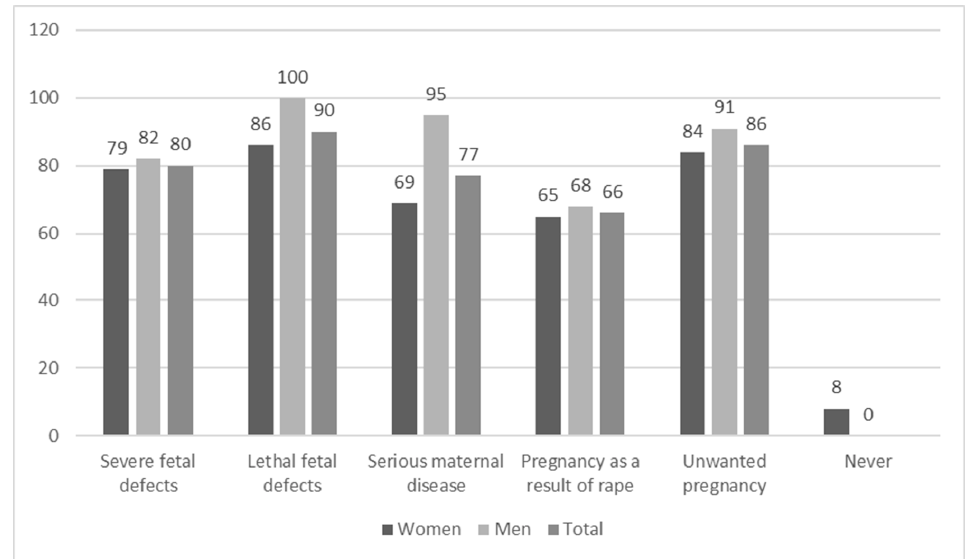
Figure 2. Declaration to perform pregnancy termination depending on the respondent’s sex (in %) .